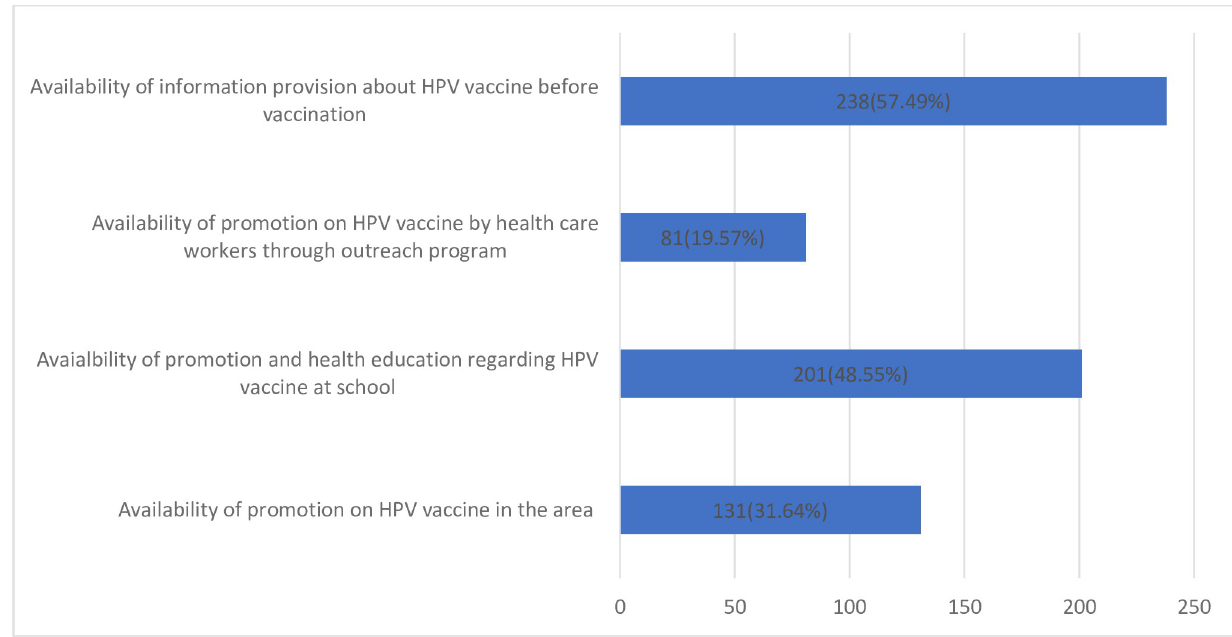
Fig 4. Existence of promotion and pre-information towards the HPV vaccine among adolescent school girls in Ambo town, Ethiopia, 2020 (n = 414). https://doi.org/10.1371/journal.pone.0271237.g004 awareness creation about cervical cancer or HPV vaccine at school were significantly associ- ated with uptake of HPV vaccination.